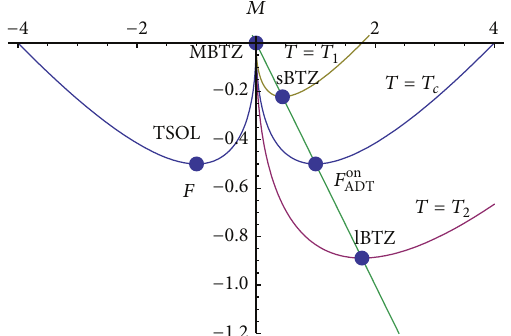
Figure 1: Hawking-Page phase transition for the SAdS with 𝑙 = 1 : the thick curve represents the on-shell free energy 𝐹 on SAdS (𝑟 + ) , while three thin curves denote the off-shell free energy 𝐹 off SAdS (𝑟 + , 𝑇) with three temperatures 𝑇 = 𝑇 1 = 0.9𝜋 −1 (< 𝑇 𝑐 ),𝑇 𝑐 = 𝜋 −1 , and 𝑇 2 = ) . − (+) denotes negative (positive) heat capacity. SBH 1.1𝜋 −1 (> 𝑇 𝑐 is bounded in the right by the line at 𝑟 + = 𝑟 ∗ = 0.57 .